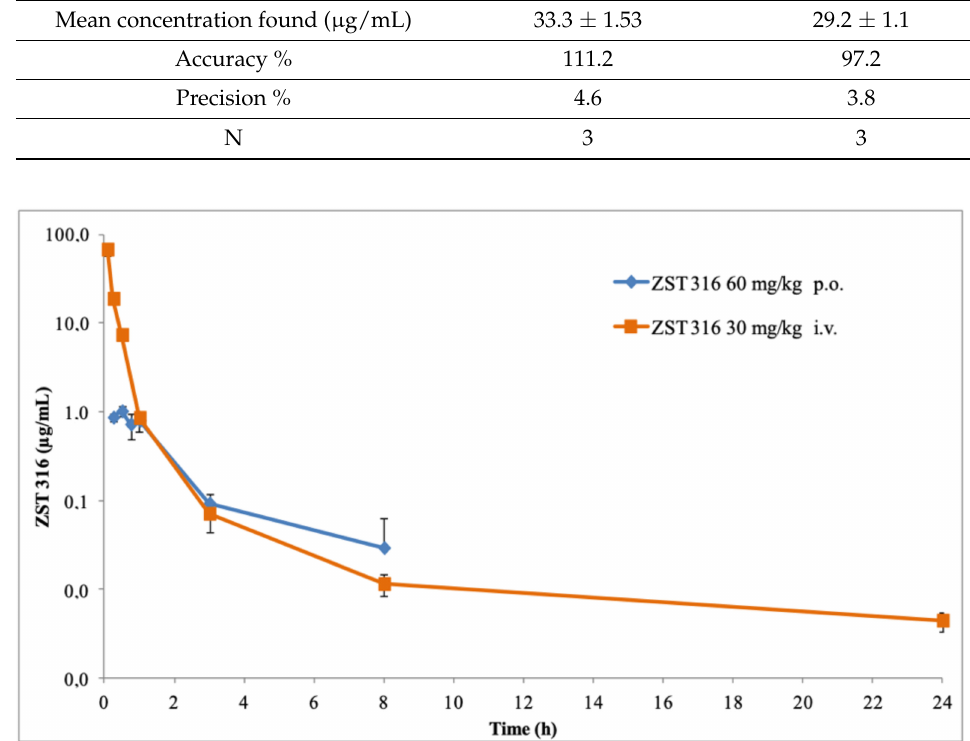
Figure 5. Plasma decay curves of ZST316 after single oral and intravenous administration.